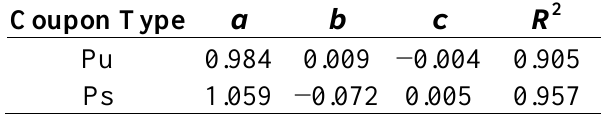
to V correlation (Figure N vN